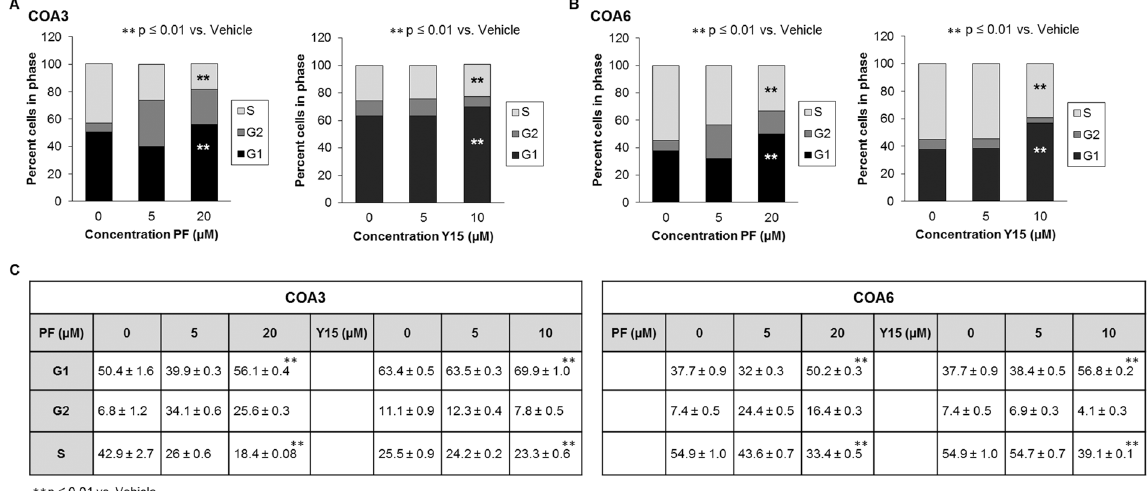
Figure 3. FAK inhibition diminished progression through the cell cycle. ( A ) COA3 cells (3 × 10 6 ) were treated with increasing doses of PF (0, 5, 20 μ M) or Y15 (0, 5, 10 μ M) for 72 hours. Cells were stained with propidium iodide and cell cycle was analyzed via flow cytometry. FAK inhibition led to an increase in percentage of cells in the G1 phase and a decrease in percentage of cells in S phase. This change was statistically significant and represents failure to progress through the cell cycle. ( B ) COA6 cells (3 × 10 6 ) were treated with increasing doses of PF (0, 5, 20 μ M) or Y15 (0, 5, 10 μ M) for 72 hours. Cells were stained with propidium iodide and cell cycle was analyzed via flow cytometry. FAK inhibition led to an increase in percentage of cells in the G1 phase and a decrease in percentage of cells in S phase. This change was also statistically significant, representing failure to progress through the cell cycle. ( C ) Cell cycle data are presented in tabular form. Data represent at least three biologic replicates and are reported as mean ± SEM.